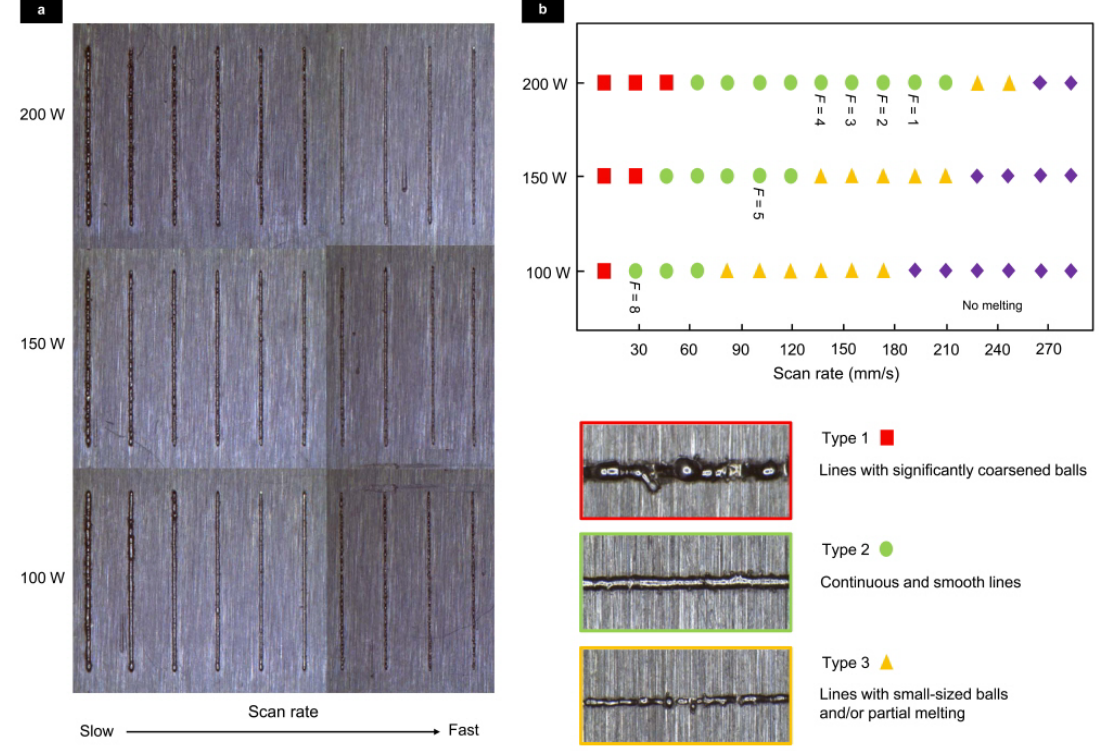
Figure 3. Photograph ( a ) and map ( b ) showing the single ‐ line formation test results. The beads obtained under six different conditions ( F (objective function) = 1–5, and 8), which resulted in the production of continuous and smooth lines (type 2), were further examined to determine the optimal process conditions (laser power and scan rate).